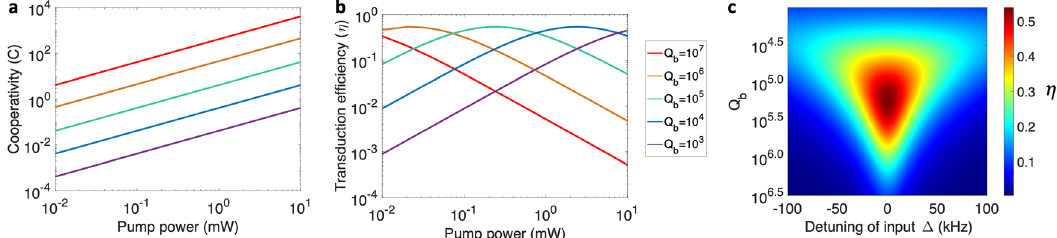
Fig. 4 Figures of merit of the transduction process. Effect of the incoming pump power on the ( a ) cooperativity and the ( b ) transduction ef fi ciency ( η ) for different values of microwave quality factors ( Q b ). c Transduction ef fi ciency as a function of Q b (in the logarithmic scale) and the frequency detuning of the optical/microwave input ( Δ , in the linear scale). The parameters are the same as in Fig. 3.